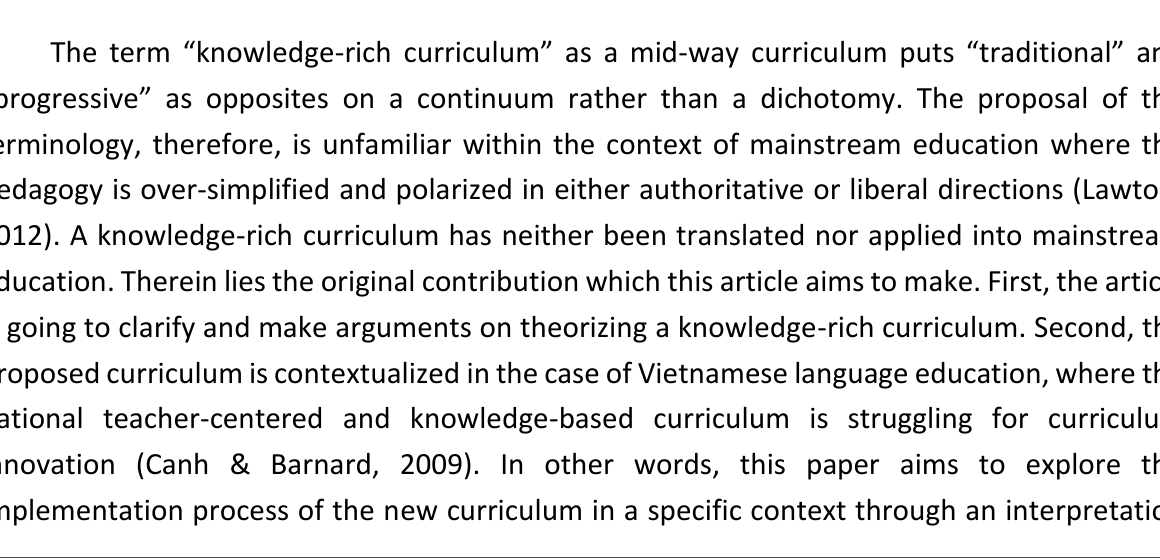
Figure 1. The spider web of curriculum components (adapted from Van den Akker,